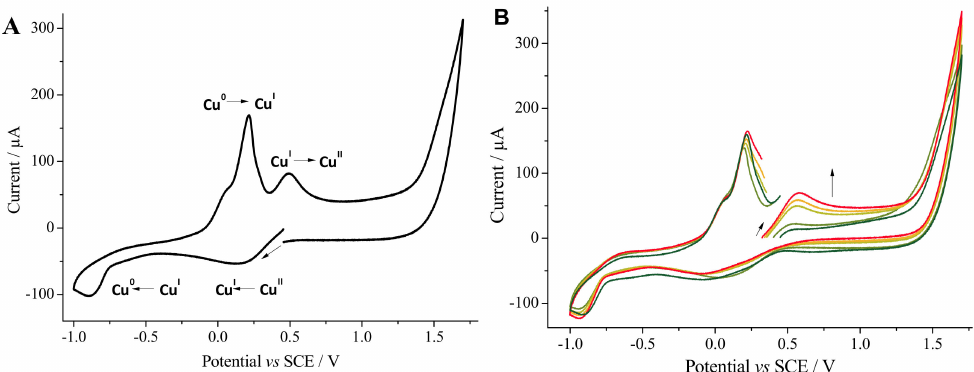
Figure 1. ( A ). Cyclic voltammogram toward reduction potentials of a solution of Cu II Cl 2 (2 mM) in MeOH (see Figure S9 for the voltammogram toward oxidation). ( B ). Cyclic voltammogram toward oxidation potentials monitoring the reduction in Cu(II) to Cu(I) by PhB(OH) 2 in the presence of TBAOH Cu II Cl 2 (2 mM, dark green). Addition of PhB(OH) 2 (10 mM, light green). Addition of TBAOH (5 mM, apple green) at t = 0. After 20 min (light orange). After 30 min (orange). After 45 min (red). Working electrode: glassy carbon (Ø = 3 mM); scan rate: 0.5 V s − 1 ; supporting electrolyte: n Bu 4 NBF 4 (0.3 M); recorded at ambient temperature starting at the open circuit potential (OCP).